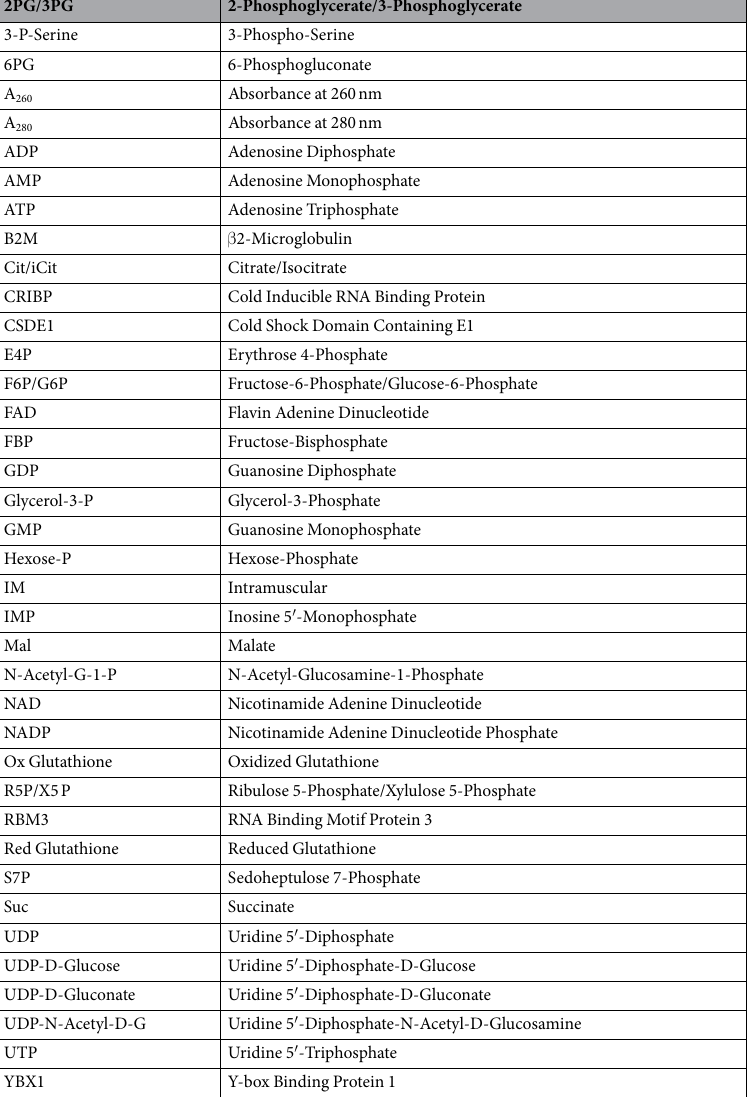
Table 1. Abbreviations used in this